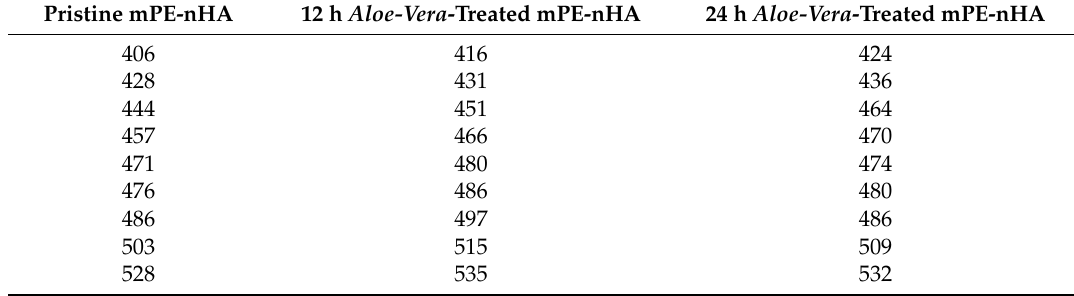
Table 1. Contact angle measurement of the mPE before and after HNO 3 treatment.